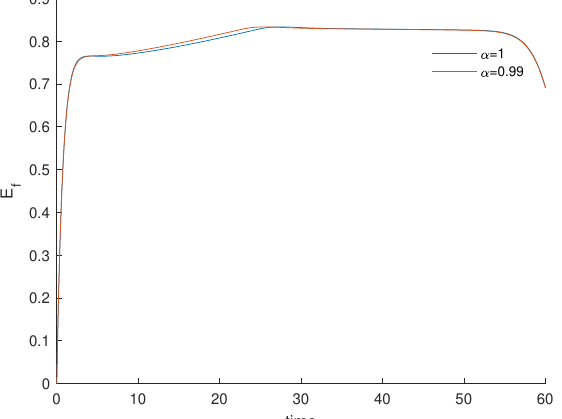
Figure 10. Evolution of the efficacy function (13) for the FOCP (4)–(7) with values in Table 1 and fractional-order derivatives α = 1.0 and α =